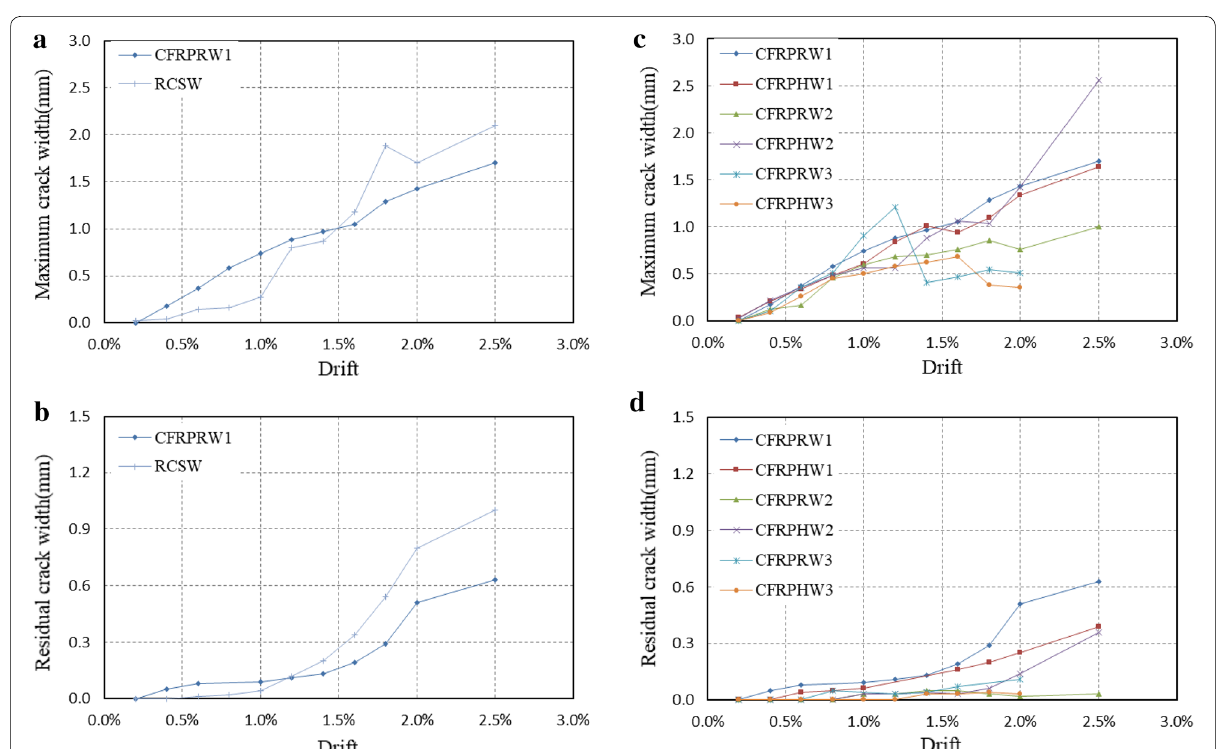
Fig. 14 Maximum crack width and residual crack width ( a – d